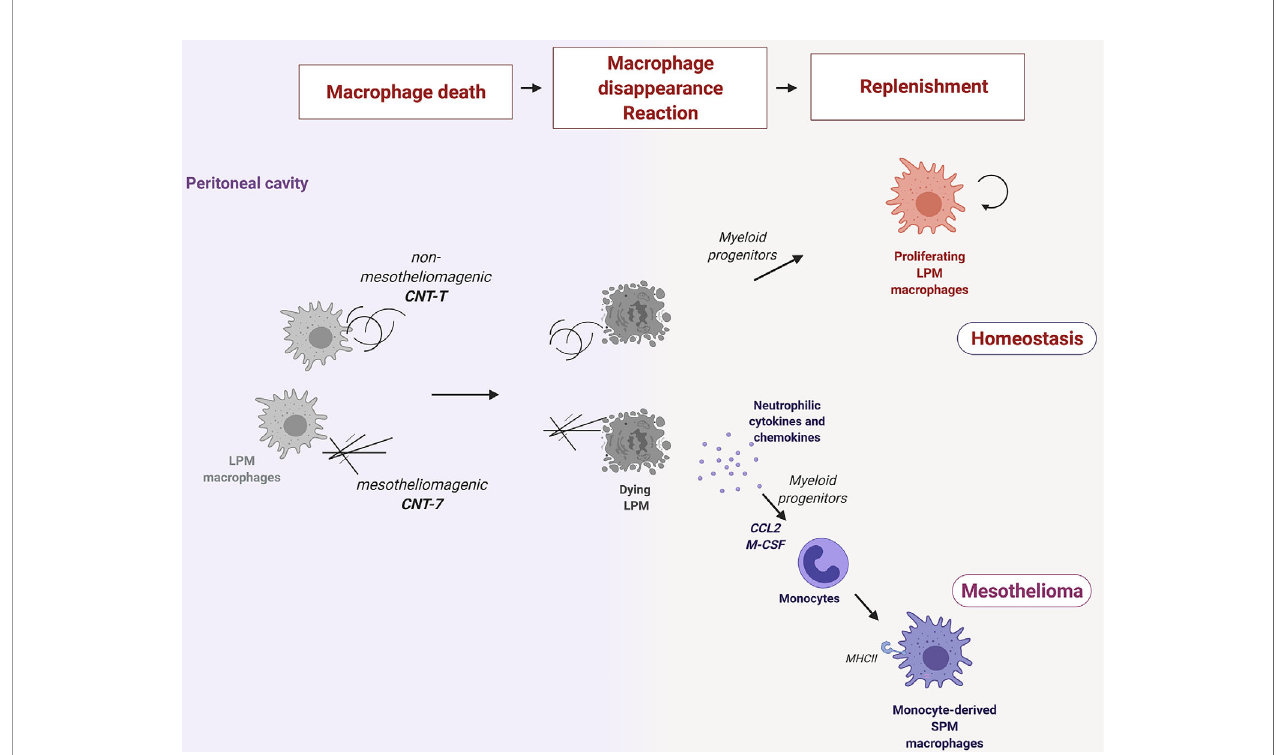
FIGURE 6 | Resident macrophages phagocytize needle-like mesotheliomagenic particles (CNT-7), die rapidly (macrophage disappearance reaction or MDR) and release pyroptosis-related in fl ammatory cytokines (IL-1 b , IL-6, and IL-17A) and chemokines (GRO/KC) to recruit neutrophils and alert the immune system. Released M-CSF and CCL2 chemokines also recruit bone marrow-derived monocytes, which then differentiate into MHCII high small peritoneal macrophage (SPM-like) to replenish the empty macrophage niche. These monocyte-derived macrophages after CNT-7 may contribute to mesothelioma by preventing T cell killer activity. A MDR is also observed after phagocytosis of non-mesotheliomagenic tangled particles (CNT-T) but in a non-in fl ammatory environment. In this case, the replenishment of the cavity relies fi rstly on myeloid monocyte differentiation and later on proliferating MHCII low large peritoneal macrophages